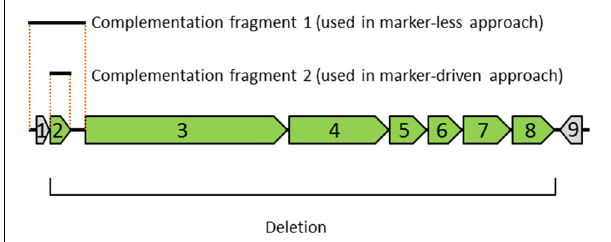
FIGURE 1 | Diagram depicting the genomic region, deletion and complementation fragments examined in this study. The genomic region contains nine genes indicated with arrows: (1) MMSYN1_0839, (2) nusG , and (3–9) MMSYN1_0841- MMSYN1_0847. The orientation of each gene is indicated (right-pointing arrow denotes a clock-wise direction in the genome). The deletion removes seven genes shown in green (genes 2–8), starting with the initiator codon of gene 2 and ending with the stop codon of gene 8. Complementation fragment 1 includes gene 1, gene 2 and their corresponding upstream and downstream intergenic regions. This complementation fragment was used in a marker-less approach (see Figure 2 ). Complementation fragment 2 includes only the ORF of gene 2. This fragment was combined with an expression vector and used in a “marker-driven”